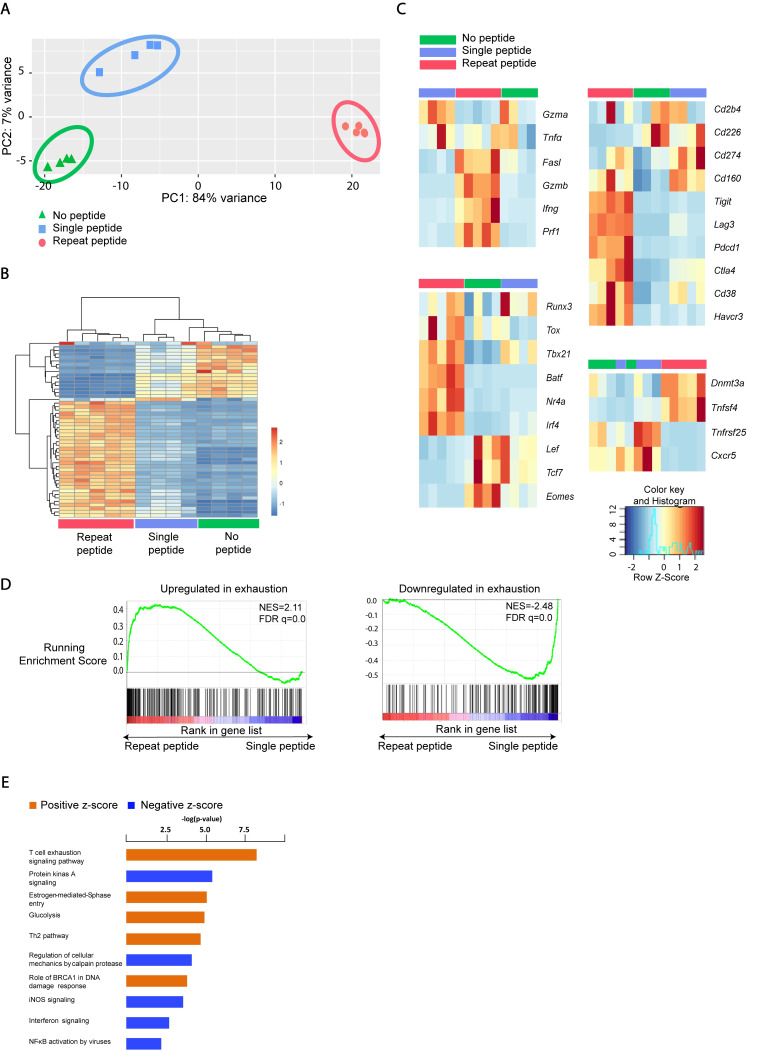
Repeat peptide stimulated cells have distinct transcriptional profile.RNAseq analysis was performed on live CD8+ T cells sorted from 5 day culture of OT-I CD8+ T cells. Cells were either without peptide (no peptide), one-time stimulation (single peptide) or daily peptide stimulations (repeat peptide). (A) PCA plot of RNA-seq data show that cells from identical culture conditions cluster together and away from each other. (B) Heatmap shown for the top 50 differentially expressed genes within CTL from the different culture conditions. (C) Heatmaps for the individual genes clustered based on function presented. (D) Repeat peptide stimulated CTL transcriptomes were enriched in gene signatures of LCMV-Cl13 exhausted CTL. Differentially expressed genes in repeat peptide stimulated CTL were analyzed by GSEA for their enrichment in gene sets found in exhausted CTL from LCMV-Cl13 infected mice. Enrichment in upregulated (left) and downregulated (right) genes shown. (E) Ingenuity pathway analysis was performed on the differentially expressed genes in repeat peptide stimulated cells (compared to single peptide). Significantly upregulated pathways (orange) and downregulated pathways (blue) in repeat peptide stimulated cells are depicted. P values (hypergeometric test) are presented as -log10.